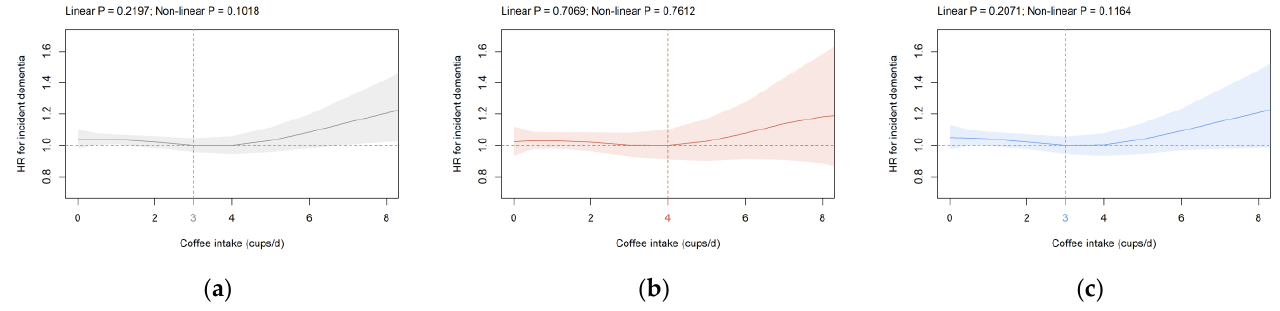
Figure 3. Association of coffee intake (cups/d) with dementia risk in the primary cohort in ( a ) all participants, ( b ) females, and ( c ) males. Data are adjusted and presented as indicated in Figure 1.